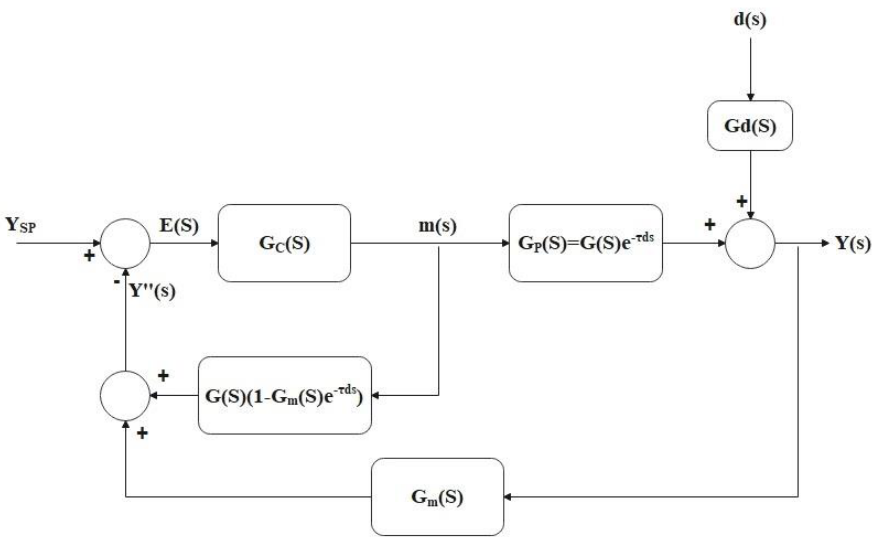
Figure 1. Smith ’s predictive control method.